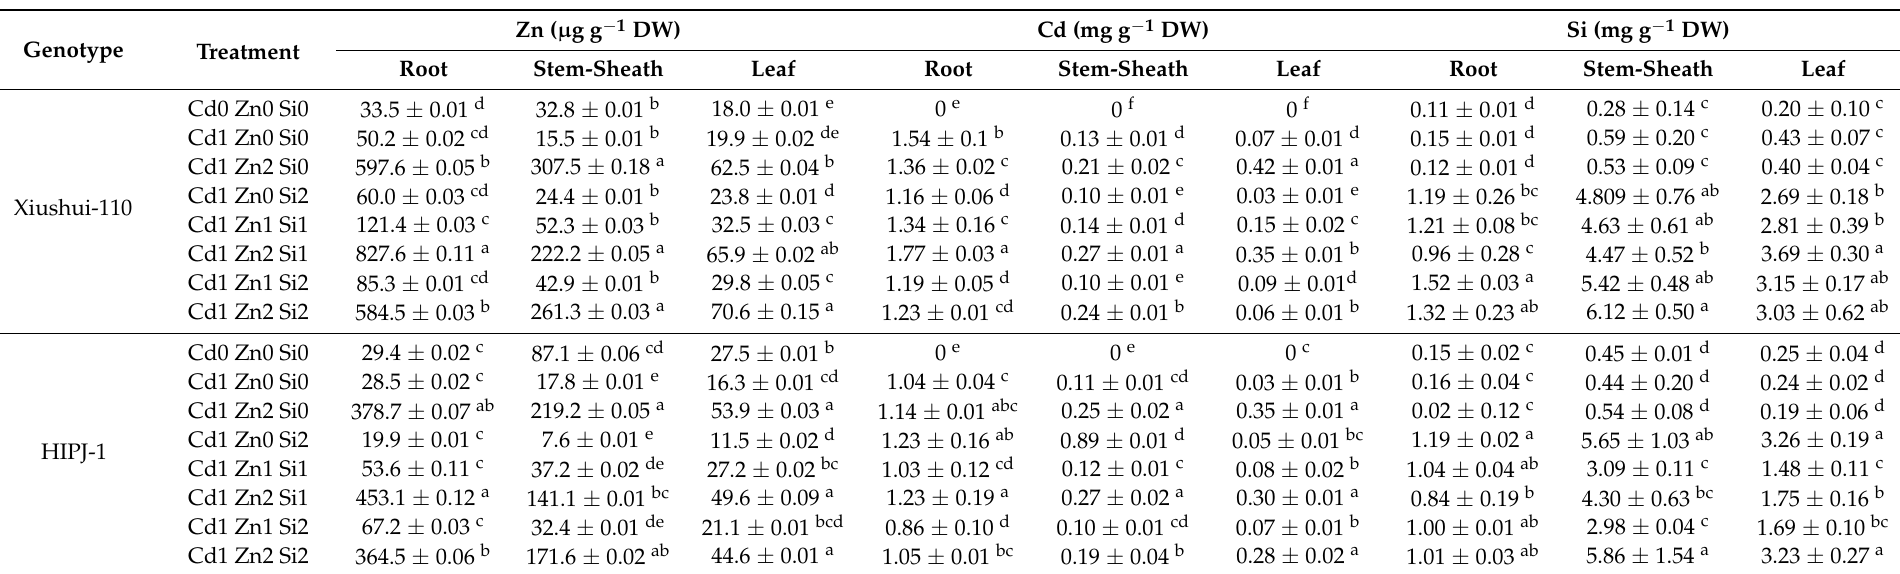
Table 2. Effect of alone and combined cadmium, zinc and silicon application (30 d) on Zn, Cd, and Si uptake for two rice